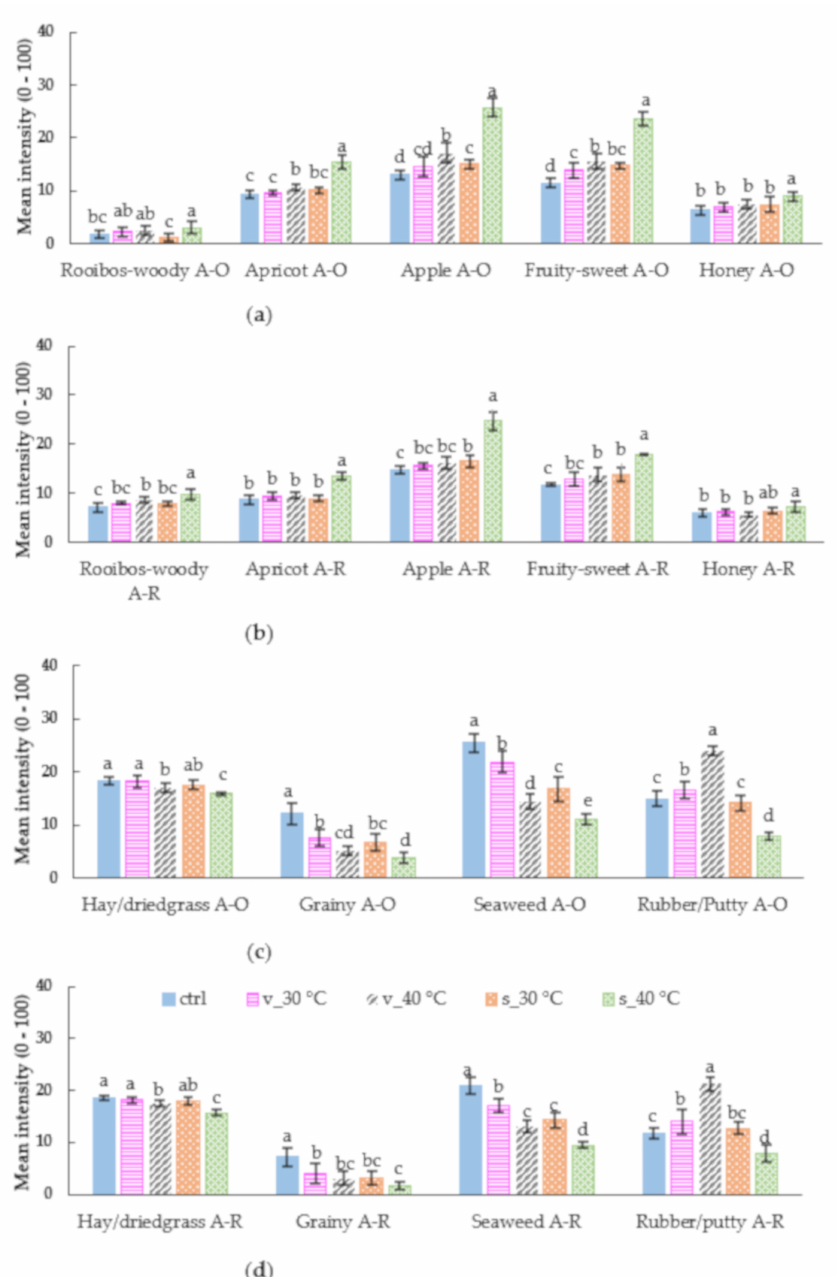
Figure 6. Mean intensities of the positive ( a ) orthonasal (A-O) and ( b ) retronasal (A-R) aroma attributes, as well the negative ( c ) orthonasal (A-O) and ( d ) retronasal (A-R) aroma attributes for M3 reconstituted in water to beverage strength (green rooibos extract microencapsulated with inulin in 1:1 ratio (m/m), xylitol, and citric acid), before storage (control, ctrl) and stored for 1 month at 30 ◦ C/65% RH and 40 ◦ C/65% RH in sealed glass vials (v) and semi-permeable sachets (s). Means with different letters, within a sensory attribute, differ significantly ( p ≤